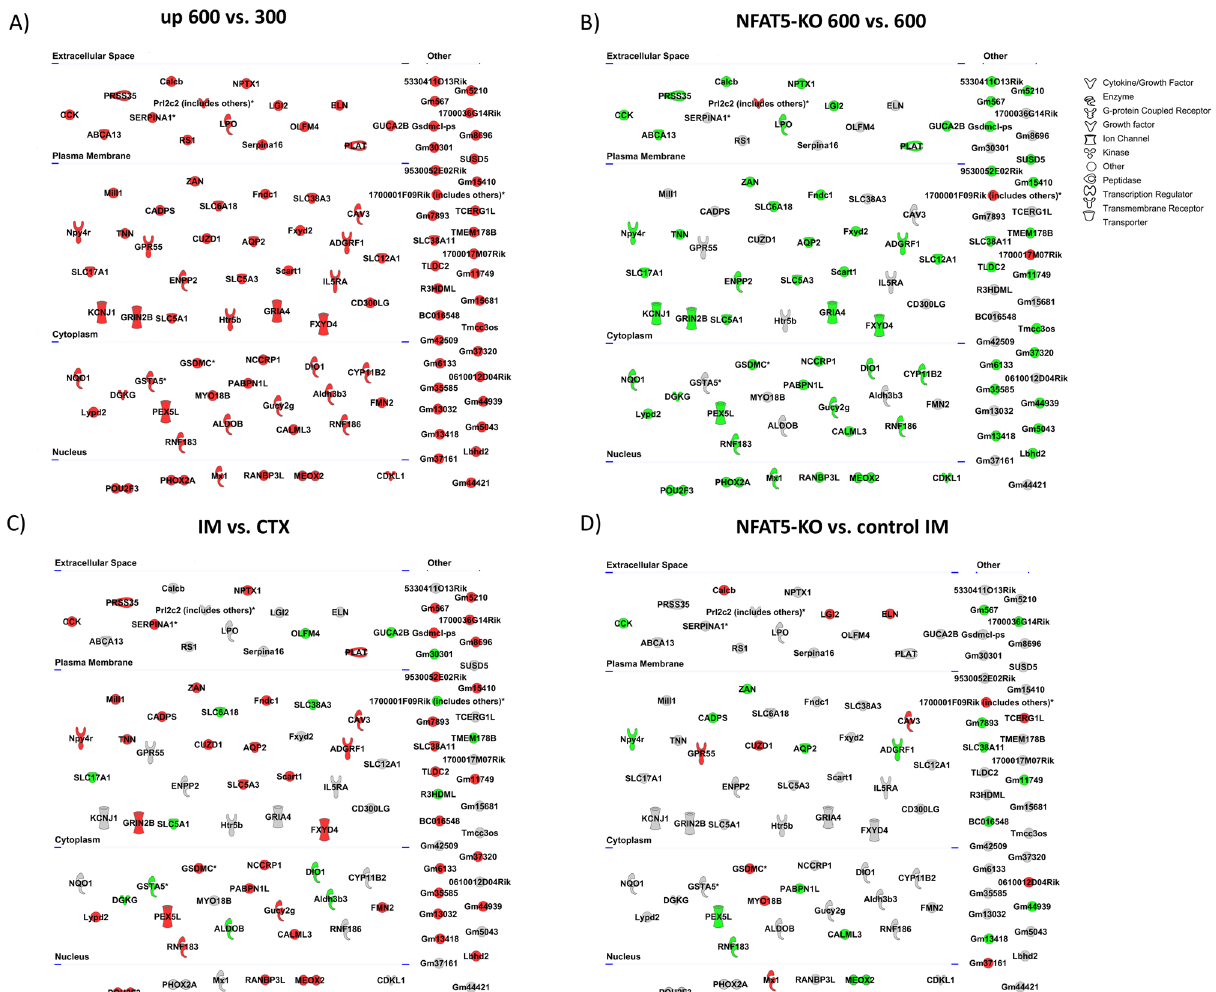
Figure 5. Top 100 genes increased under hypertonic conditions in IMCD cells. ( A ) Top 100 up regulated transcripts and their predicted subcellular localization in primary IMCD cells cultivated at 600 mosmol/ kg compared to control conditions (300 mosmol/kg). ( B ) Changes in expression level in NFAT5-KO cells compared to control cells, cultivated at 600 mosmol/kg. ( C ) observed changes in renal IM vs. CTX. ( D ) Changes between NFAT5-KO IM vs control IM. The color shows the direction of regulation (green = decreased with log2 fold change < − 1; red = increased with log2 fold change > 1). Transcripts that did not met the criteria are labeled in